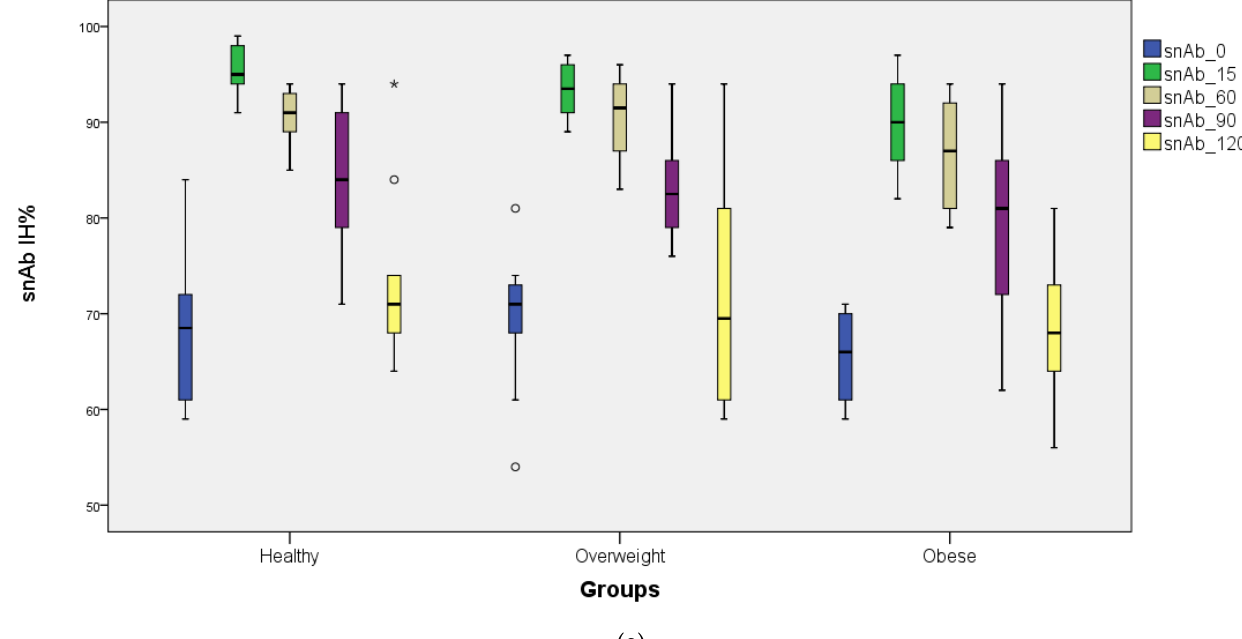
Figure 1. ( a ) Distribution of anti-S-RBD IgG antibody titers (AU/mL) before and after the third dose of BNT162b2 vaccine (on the 15th, 60th, 90th, and 120th days) for all groups (box plots). ( b ) Distri- bution of anti-S-RBD IgG antibody titers (AU/mL) before and after the third dose of BNT162b2 vac- cine (on the 15th, 60th, 90th, and 120th days) for all groups (line plots).